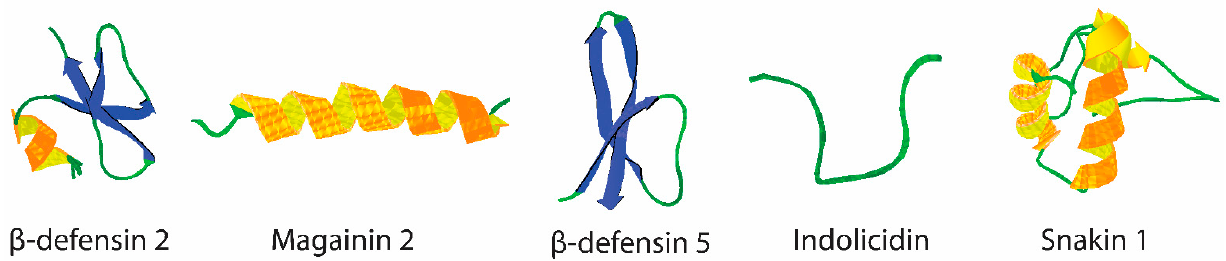
Figure 1. Examples of HDPs with diverse structures. The molecular models were reproduced from the RCSB Protein Databank (http://www.rcsb.org/pdb/home/home.do). β -defensin 2, 1W2E; magainin 2, 2MAG; α -defensin 5, 1ZMP; Indolicidin, 1G89; Snakin 1, 5E5Q.